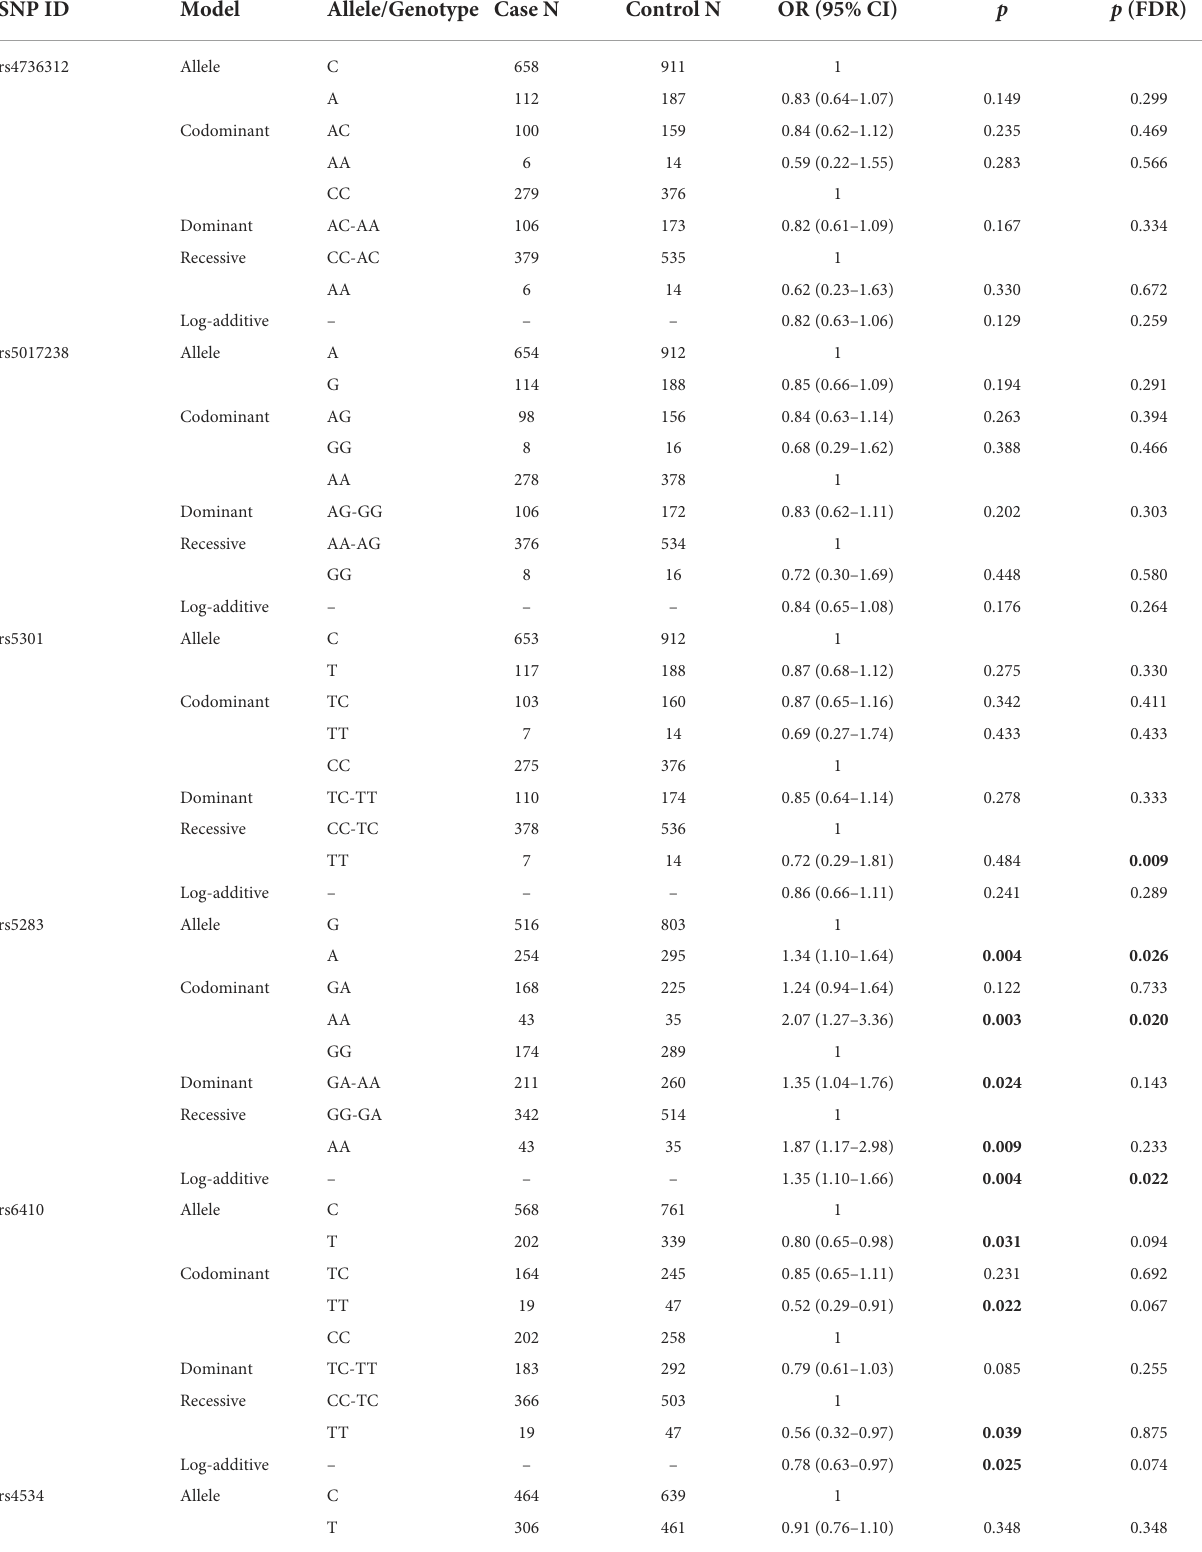
TABLE 6 The relationship between CYP11B1 polymorphisms and the risk of ischemic stroke complicated with